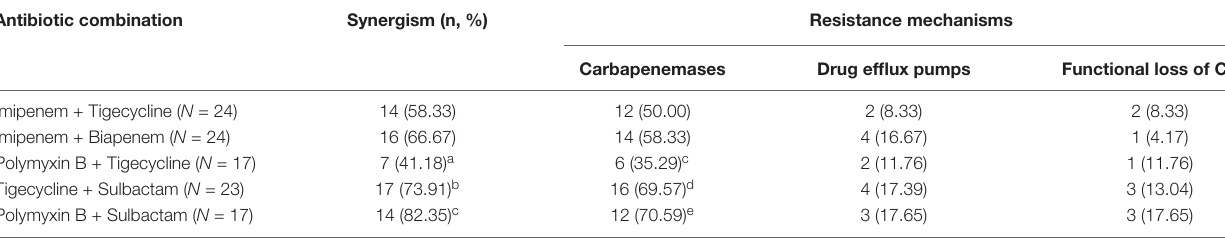
TABLE 3 | The synergistic effect of drug combinations in carbapenem-resistant Acinetobacter baumannii with different resistance mechanisms. Antibiotic combination